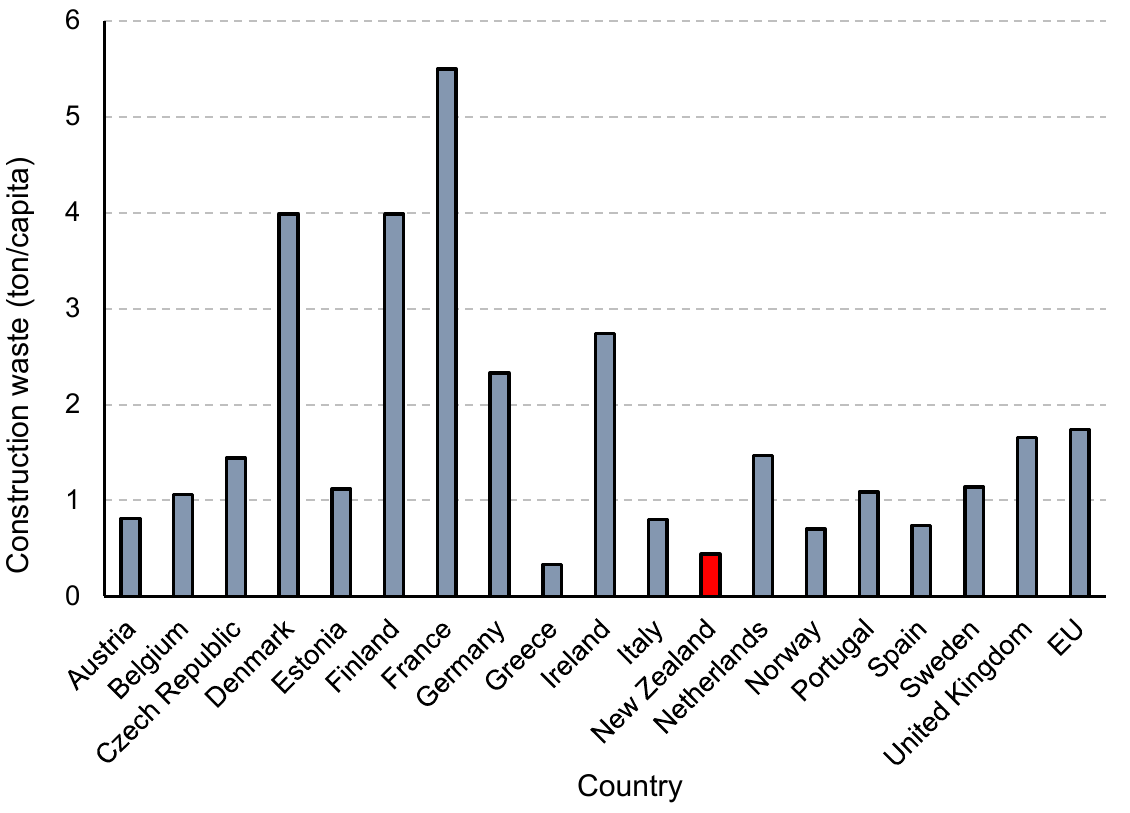
Figure 6. Generation of construction waste (tons/capita) in various countries.